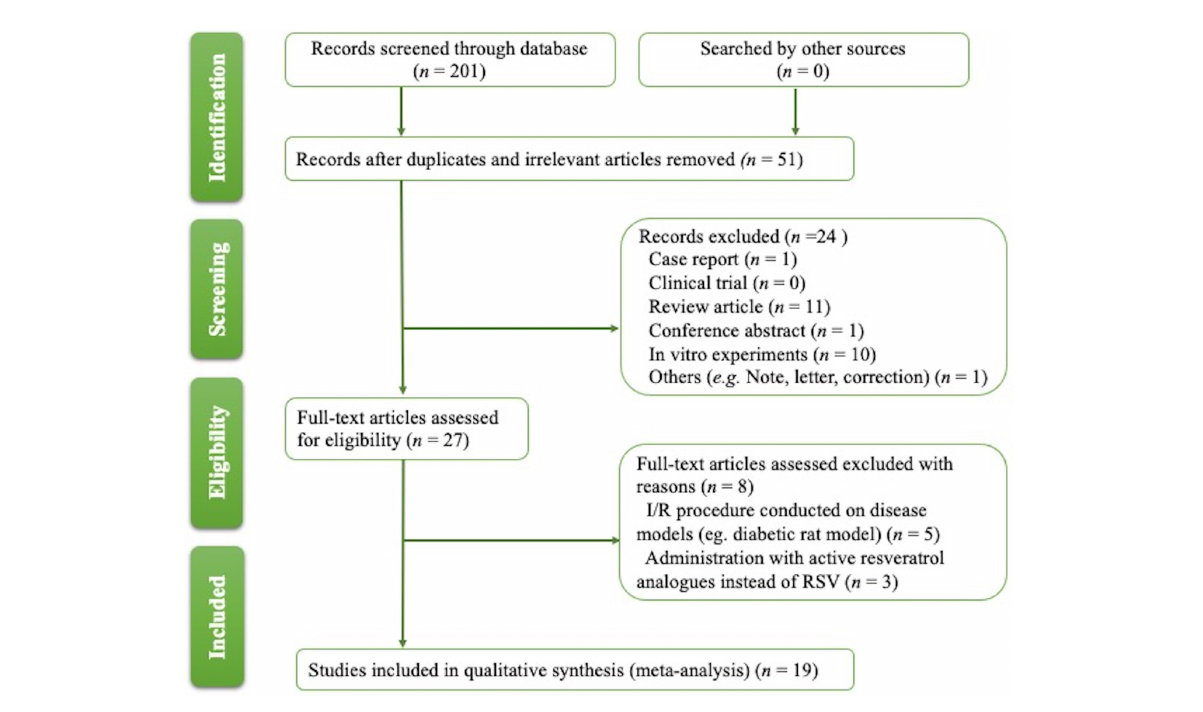
FIGURE1 Summary of the literature identification and selection